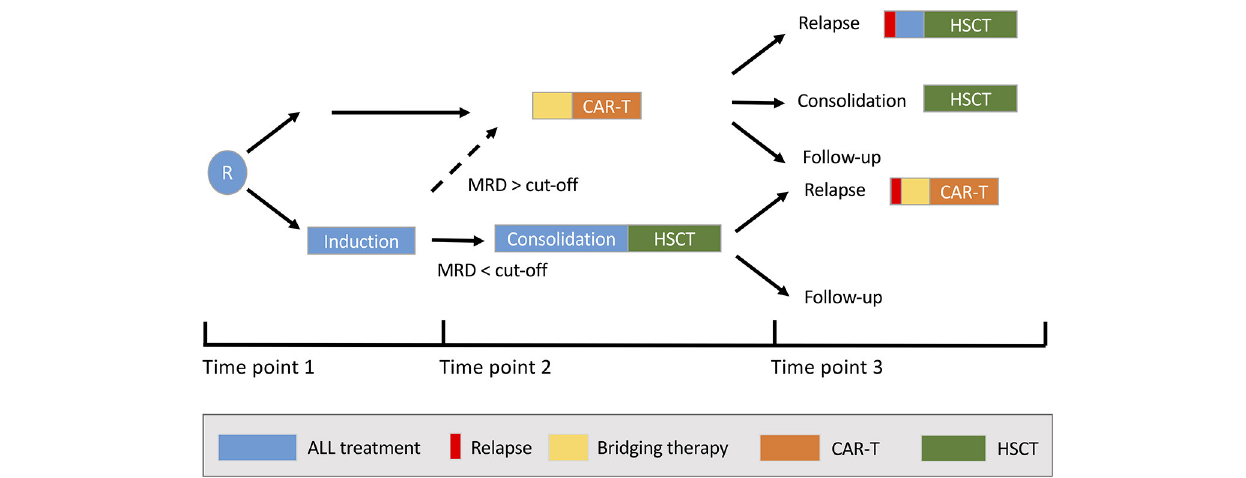
FIGURE 4 | Potential study design for a randomised study comparing chimeric antigen receptor (CAR) T-cell therapy with allogeneic haematopoietic stem cell transplantation (HSCT) in children with a first relapse of B-cell precursor acute lymphoblastic leukaemia. MRD, minimal residual disease; R,